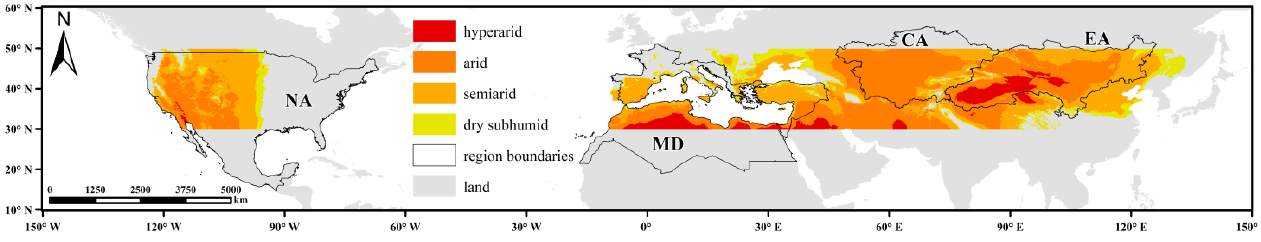
Figure 1. Distribution map of the drylands between 30 – 50°N.